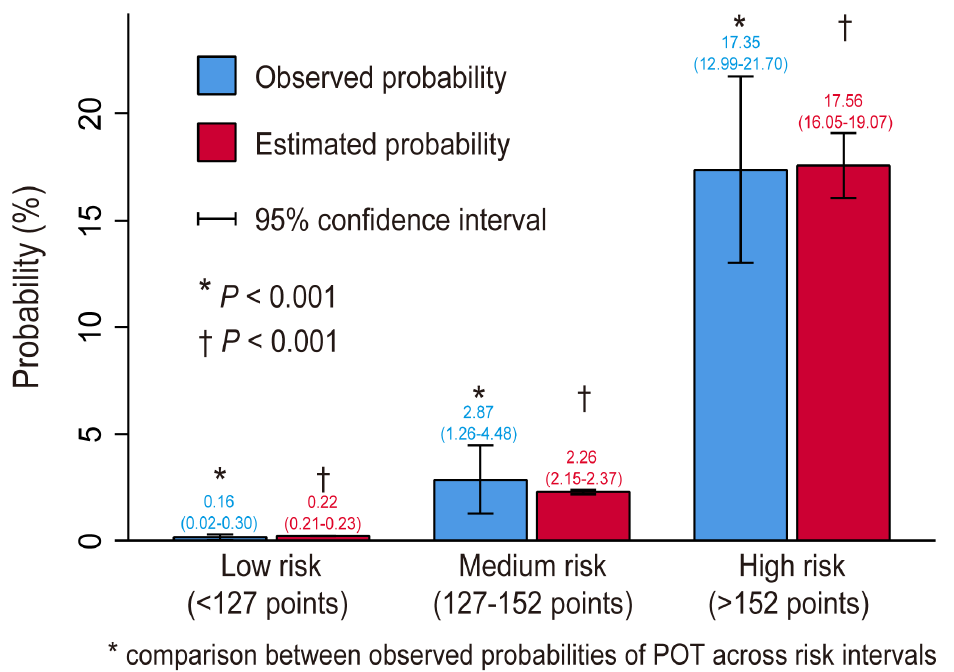
Figure 4. Bar chart showing the consistency between the observed and estimated probabilities. The difference between the observed and estimated probabilities in the same risk interval was not significant ( p > 0.05) but the difference was significant between different risk intervals ( p < 0.05), demonstrating good consistency and reasonable division.